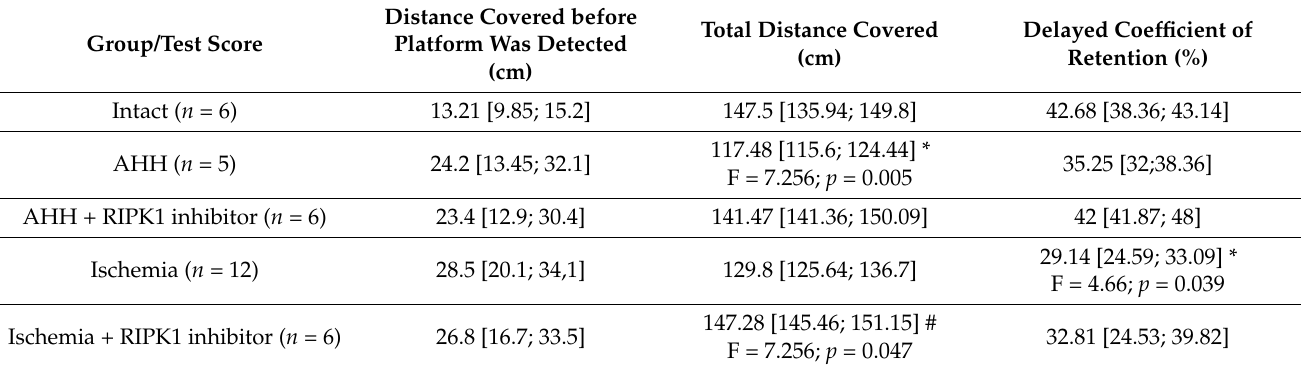
Table 3. The main indicators of delayed testing of experimental animals in the Morris water maze in modeling acute hypobaric hypoxia and cerebral